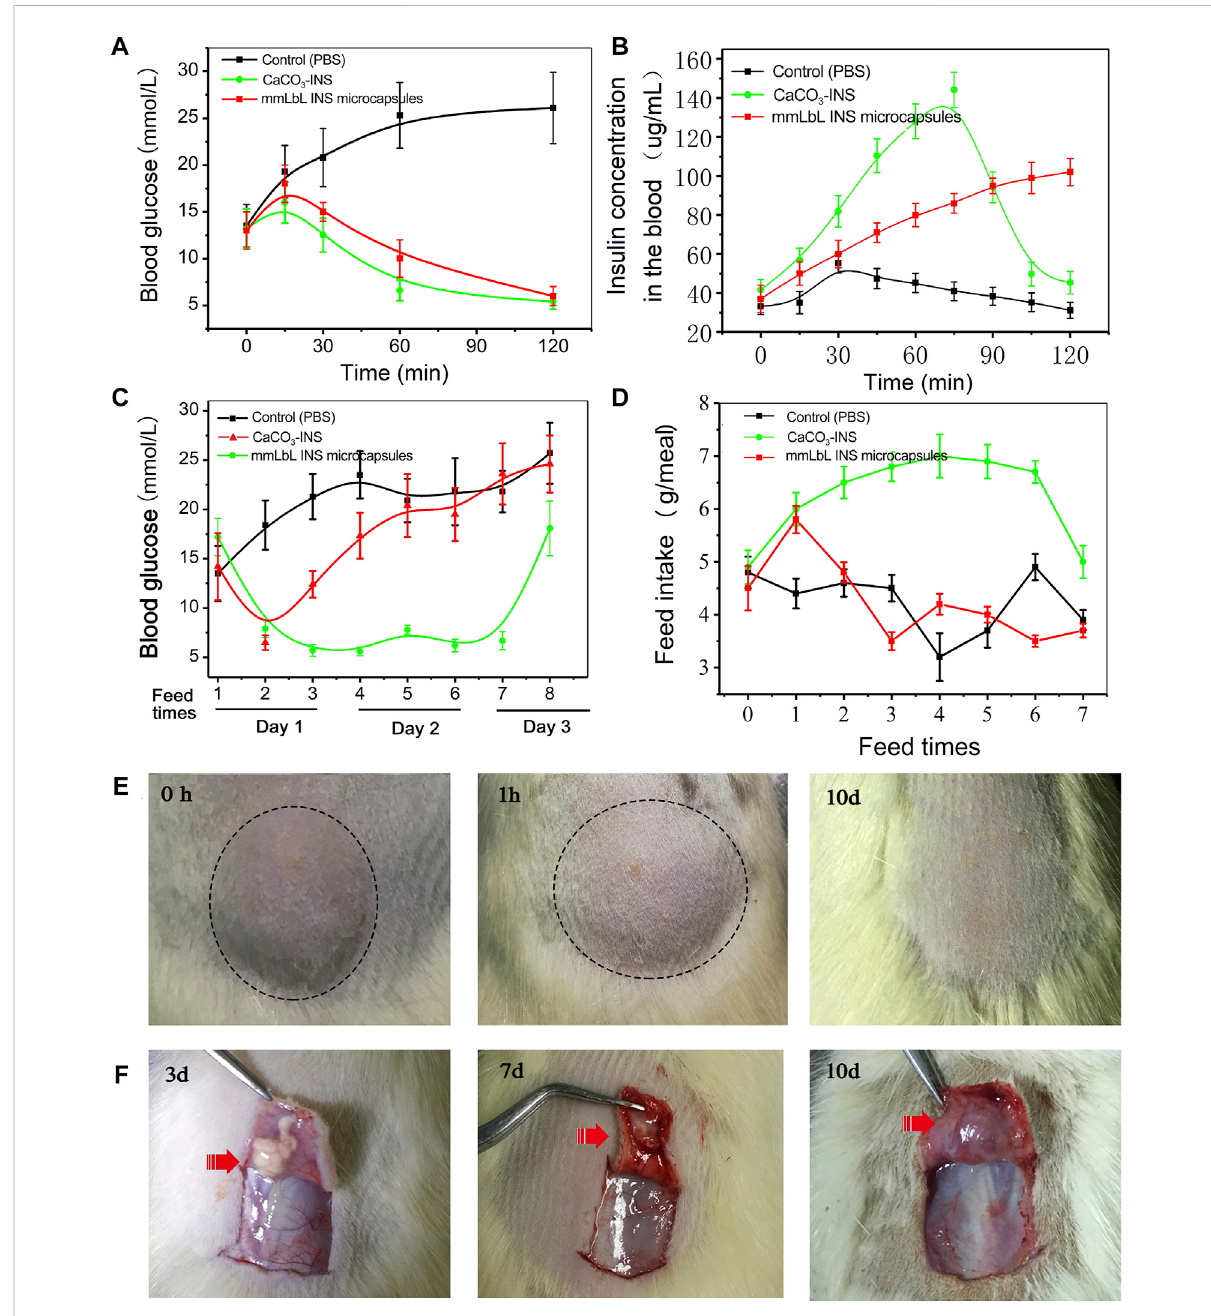
FIGURE 5 In vivo glycemic control tests results of mmLbL-INS microcapsules. (A) Change in glucose concentrations and (B) change in the INS concentration of the whole blood in the oral glucose tolerance test. (C) Long-term plasma blood glucose concentration. (D) Food intake in diabetic ratsadministeredSTZ. (E) PicturesoftheinjectedsetofmmLbL-INSmicrocapsulesondifferentdays. (F) ThechangeofmmLbL-INSmicrocapsulesin